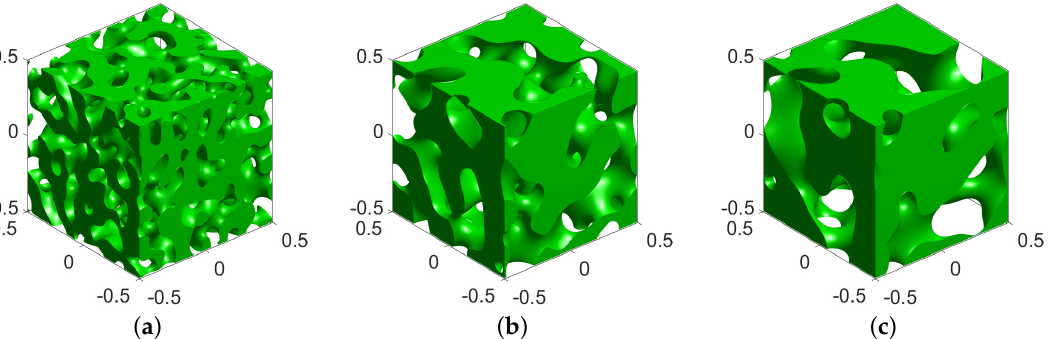
Figure 27. With the initial condition (81) , ( a – c ) are the snapshots of zero level set to the numerical solutions of the CH equation using the Fourier-spectral method after 100, 500 and 1000 iterations with ∆ t = 0.001, respectively.